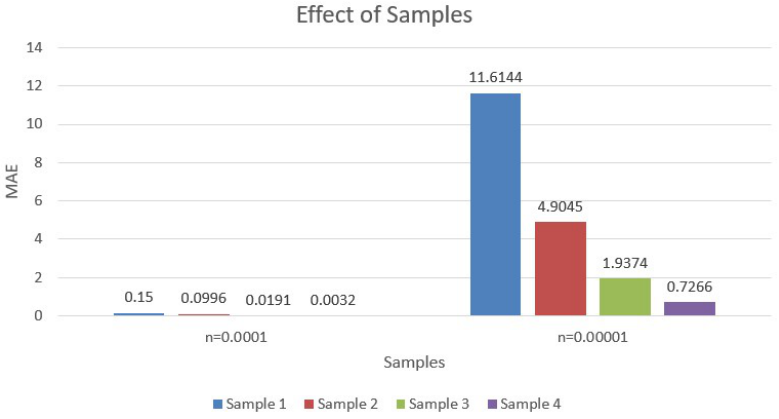
Figure 10. Performance evaluated on the test set for each sample set.